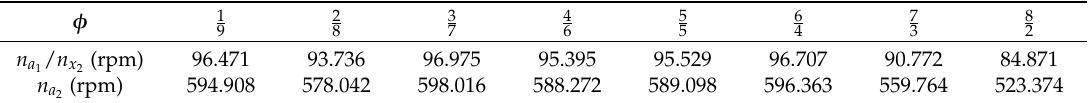
Table 4. The rotational speed of the sun gear of second planetary stage.